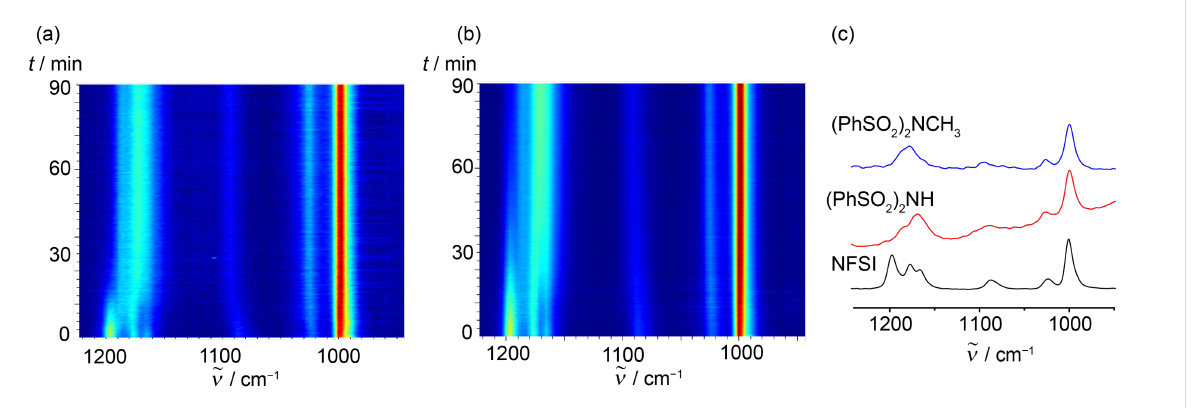
Figure 1: Time-resolved 2D plots of the mechanochemical reaction of: (a) 1c (0.59 mmol), NFSI (1.0 equiv), and SiO 2 (300 mg). (b) 1c (0.59 mmol), NFSI (2.0 equiv), and SiO 2 (300 mg). Both reactions were carried out at 30 Hz using milling jars made of PMMA (15 mL of internal volume) with one ZrO 2 milling ball (3.4 g). (c) Raman spectra of pure NFSI, (PhSO 2 ) 2 NH, and (PhSO 2 ) 2 NCH 3